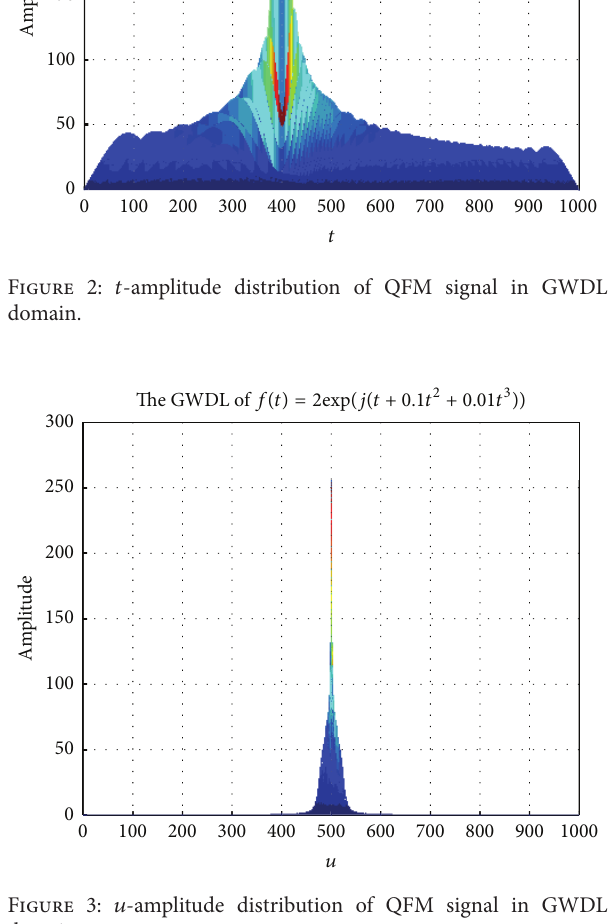
Figure 3: 𝑢 -amplitude distribution of QFM signal in GWDL